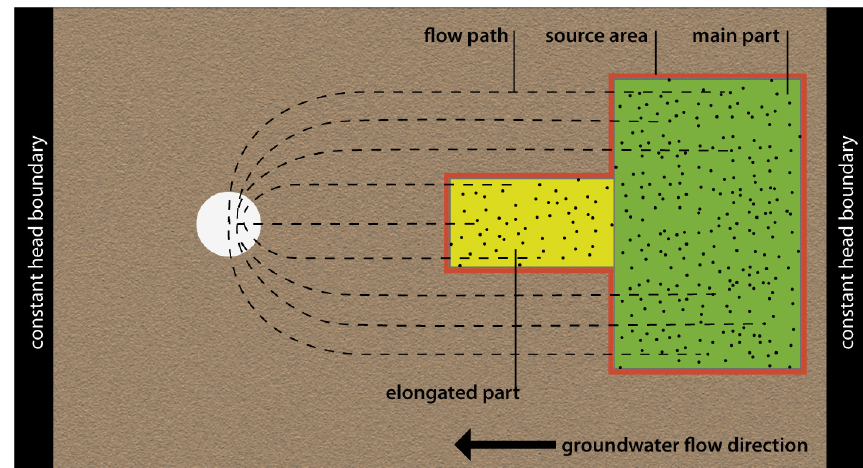
Fig. 2. Schematic representation of the conceptual framework to numerically determine the source area, plan view (compare to Fig. 1): The recharge location of particles (black dots) entering the well is determined by backward-tracking along the flow paths from the well to the water table (recharge) surface (Horn and Harter, 2009). To geometrically describe the source area, the two distinguishable particle clusters are enclosed by two rectangles. This leads to a source area (orange) consisting of a main part (green) with a narrower elongated part (yellow) extending towards the well. Based on the 3-D simulation results, the geometric shapes are parameterized as a function of aquifer and gravel pack hydraulic conductivities (Horn and Harter,